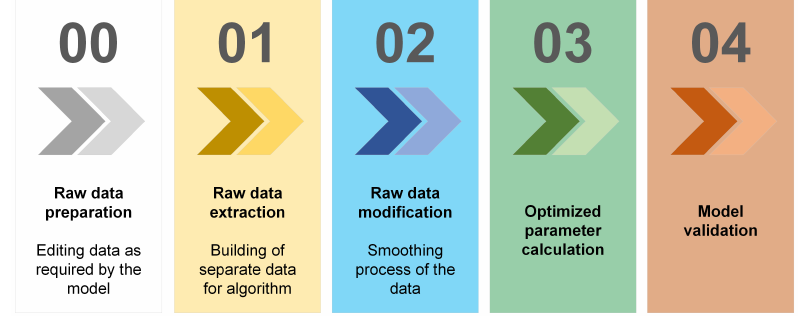
Figure 1. Method of the simulation model with steps one to four as proposed in [1] and extended raw data preparation step